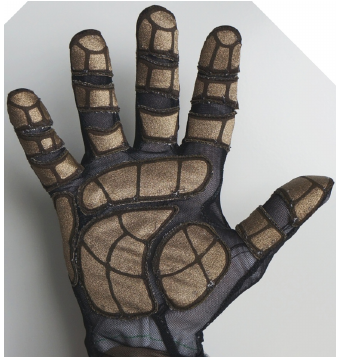
Figure 8. Tactile-sensing glove composed from various sensing patches sewed onto a very thin and breathable base glove. Individual sensing patches are further subdivided into taxels by etching away the conductive silver coating. The corresponding insulating gaps are clearly visible as dark lines in contrast to the bright taxels